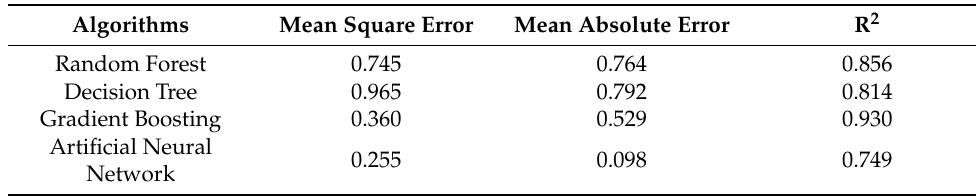
Table 3. Metrics features of Regression Based